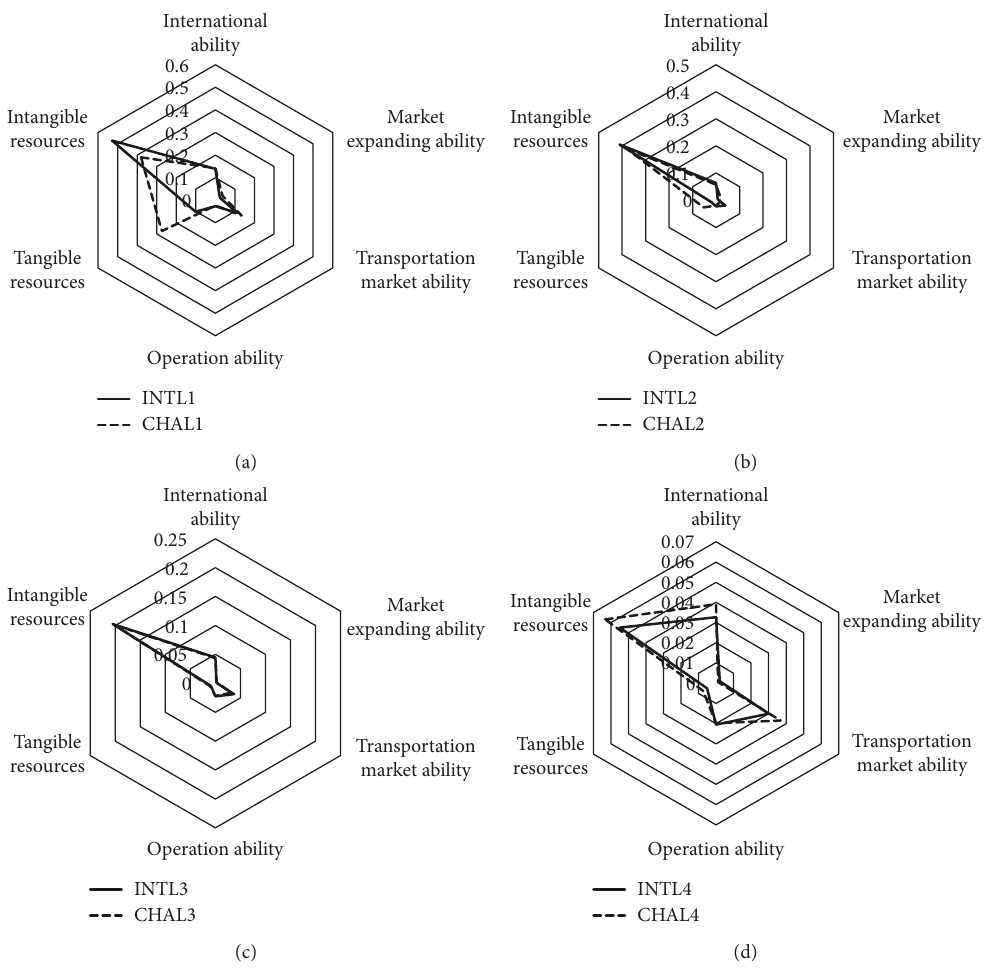
Figure 6: Comparisons between Chinese and international